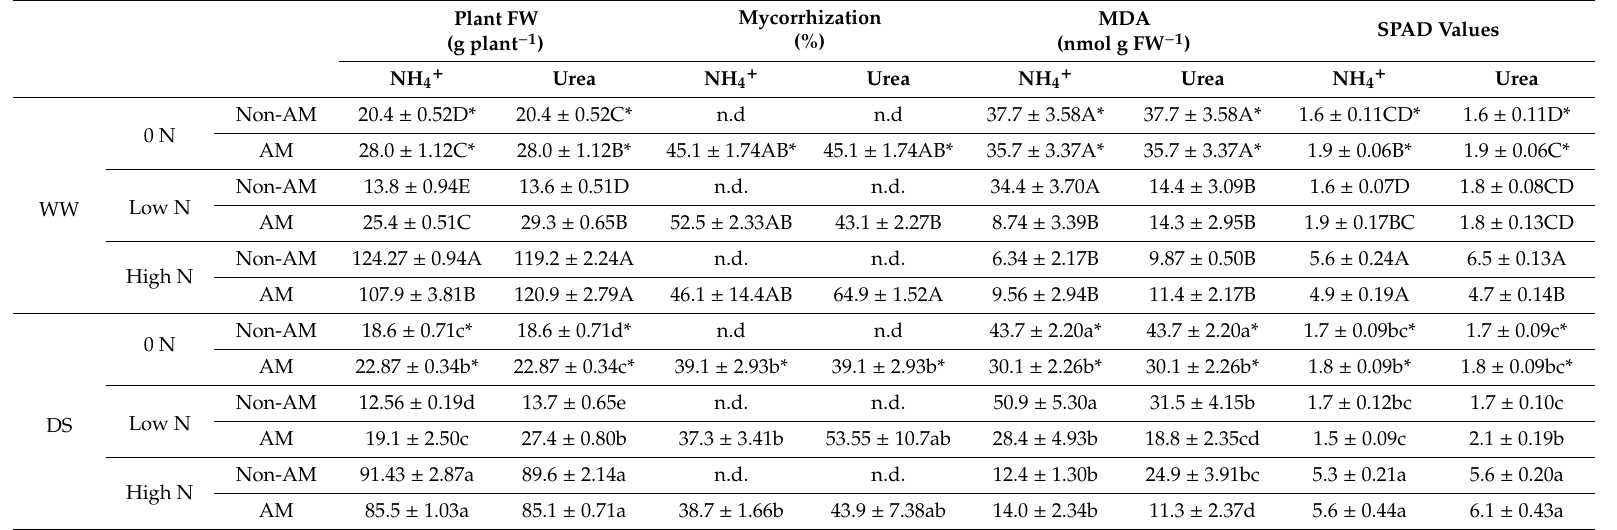
Data represents the means of six biological replicates ± SE for plant dry weight, three biological replicates ± SE for mycorrhization and MDA and six biological replicates for SPAD. Di ff erent letter (uppercase for WW treatments and lowercase for DS treatments) indicates significant di ff erences between treatments ( p < 0.05) based on Duncan’s test. Asterisks indicate that the plants cultivated with 0 N are common to the NH 4 + and the urea experiments. n.d. means